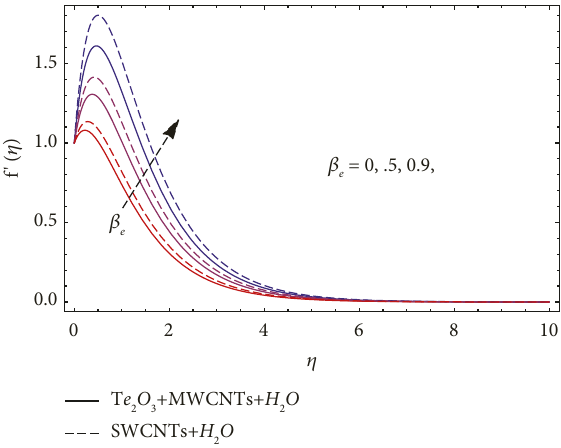
Figure 5: Influence of hall parameter on velocity profile in x direction.